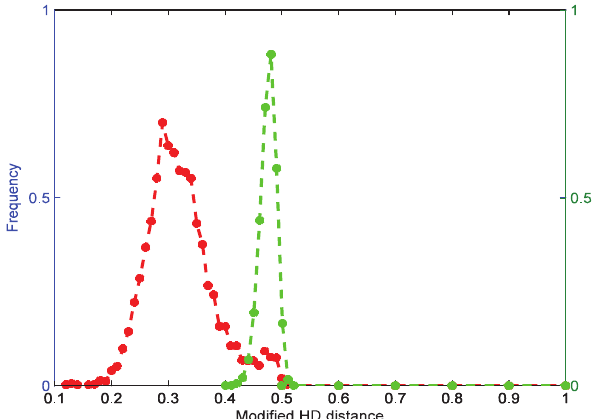
Figure 22. Distribution of Intra-class and Inter-class Modified HDs Using the CASIAV3 Data